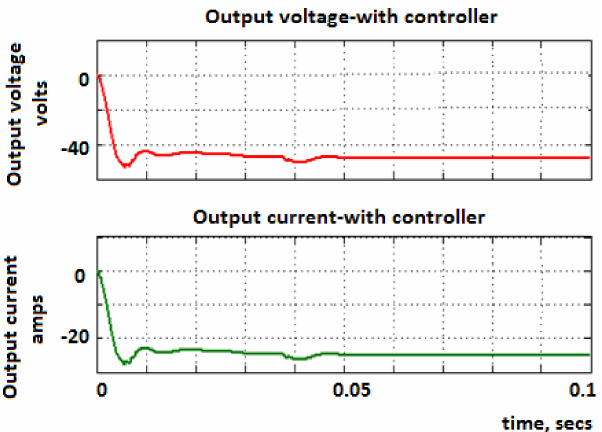
Figure 8. Final output voltage and current.